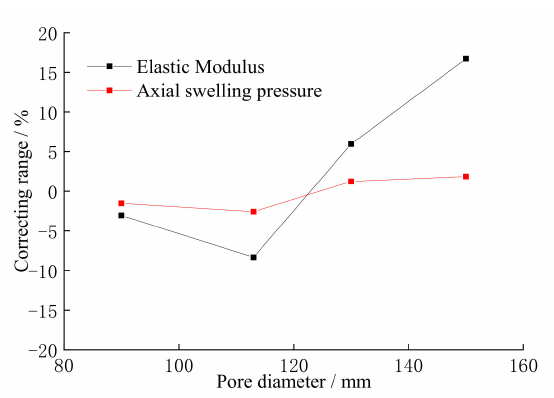
Figure 8. Sensitivity analysis for elastic modulus and axial expansive